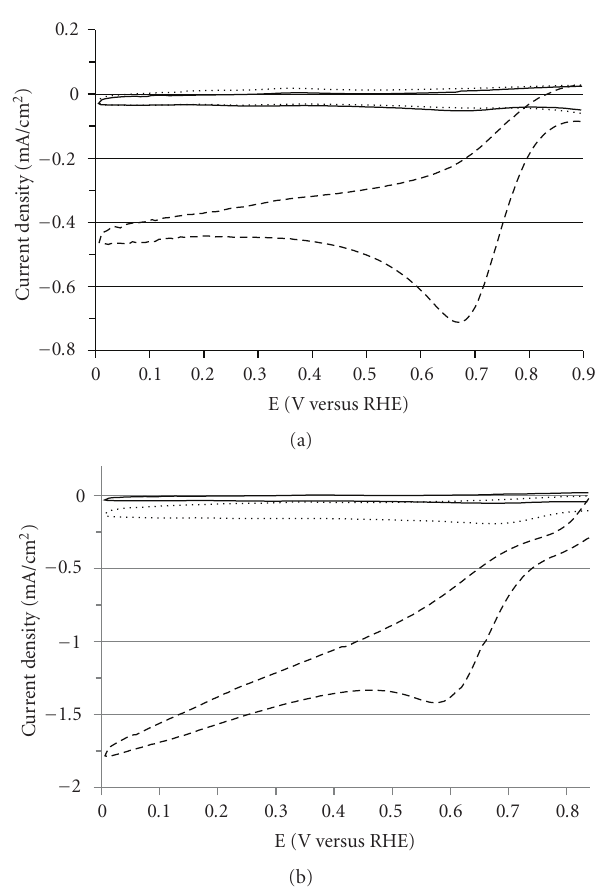
Figure 3: (a) Cyclic voltammetry of Ag electrode (1.6mm diameter disk) in 0.1M NaOH electrolyte. Solid: N 2 purge, dotted: H 2 purge, and dashed: O 2 purge. Voltammograms were conducted under saturated conditions at 50mV/sec over a voltage range of 0.0– 1.4V versus RHE. (b) Cyclic voltammetry of Ag electrode (1.6mm diameter disk) in 0.1M NaOH electrolyte. Solid: N 2 purge, dotted: xM H 2 O 2 with N 2 purge, and dashed: 10 xM H 2 O 2 with N 2 purge. Exact concentrations were unknown due to H 2 O 2 degradation, but were on the order of 1mM and 10mM H 2 O 2 . Scans were conducted under saturated conditionsat 50mV/sec over a voltage range of 0.0– 1.4V versus RHE.